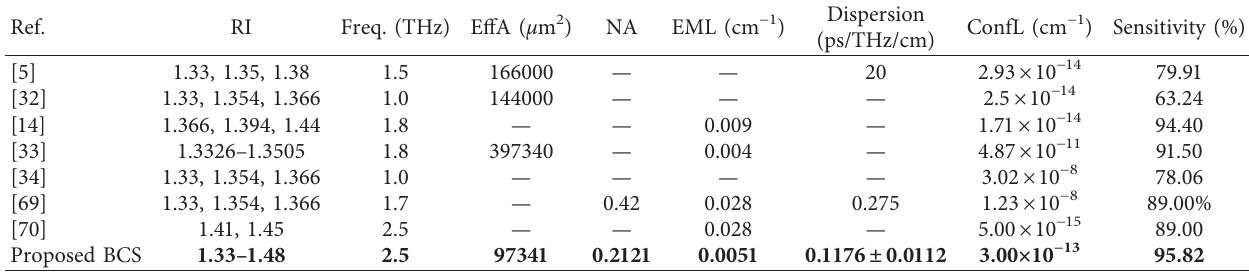
Table 5: Comparison of the proposed BCS with existing sensors.